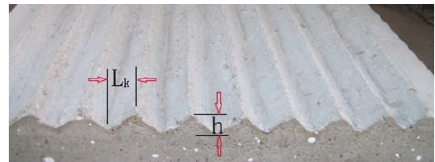
Figure 13: The topography parameters of the concrete plate used in the